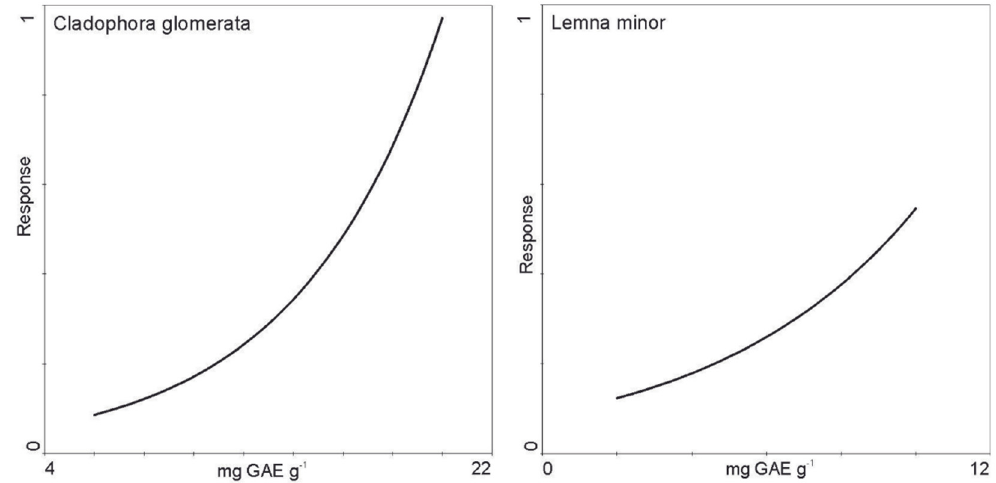
Figure 7. C. glomerata and L. minor response curves to time of polyphenol gradient modeled by the generalized additive model using Poisson distribution smooth term complexity selected according to the AIC criterion. The first axis represents the GAE, and the second axis represents the dry mass.